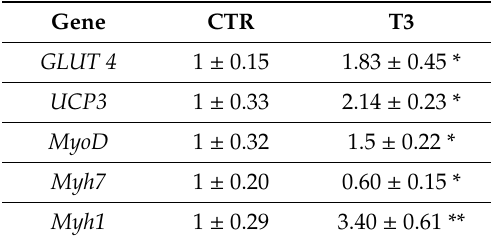
Table 1. Validation of T3 administration. Expression levels of T3-target genes in skeletal muscle of controls and T3-treated mice. Data are expressed as mean ± standard deviation. n = 4 per